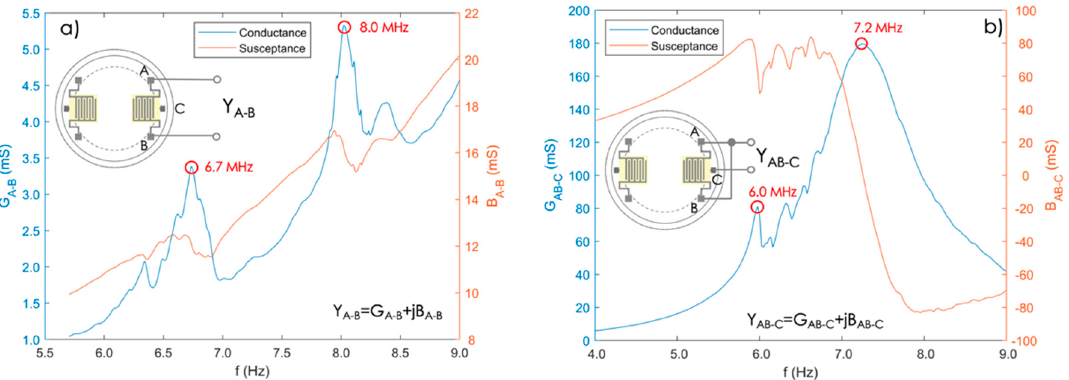
Figure 4. Measured admittance Y A-B ( a ) and Y AB-C ( b ) as functions of frequency. The plots show resonances at frequencies around 6.7 and 8.0 MHz ( a ) and around 6.0 and 7.2 MHz ( b ).